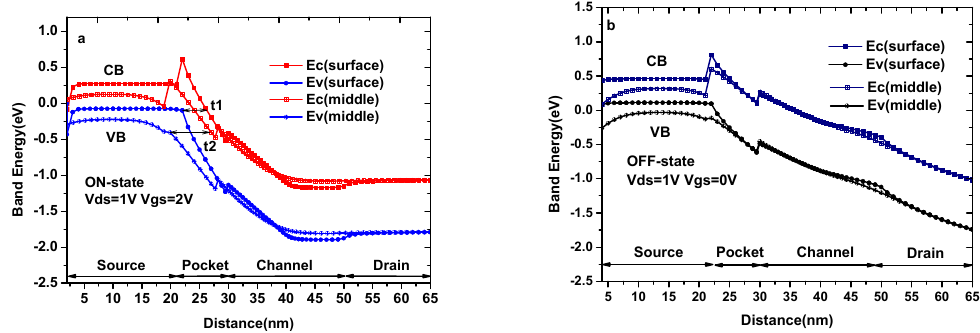
Figure 3. ( a ) The ON-state energy band diagram of DMG-HJLTFET; ( b ) The OFF-state energy band diagram of DMG-HJLTFET.